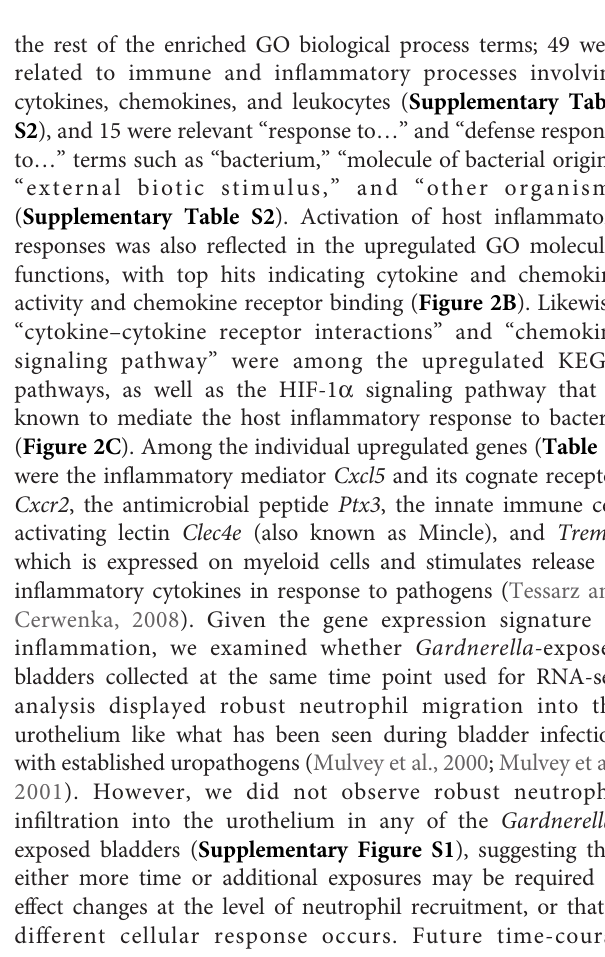
FIGURE 1 | Gardnerella exposures alter the bladder transcriptome. (A) Schematic of the urinary tract exposure model used for RNA-seq. Female C57BL/6 mice were given intravesical “ urinary tract exposures ” of either PBS or Gardnerella via transurethral catheterization. Each mouse received two exposures that were administered 12 h apart. Bladders were collected 12 h after the second exposure and processed for RNA-seq. Gardnerella -exposed bladders were compared to PBS-exposed control bladders to identify differentially expressed genes and for gene set enrichment analyses. (B) MA-plot indicates genes that had altered expression in Gardnerella compared to PBS bladders. Red dots denote genes that were signi fi cantly differentially expressed after false discovery rate (FDR) correction for multiple comparisons. Genes discussed in the text are indicated by